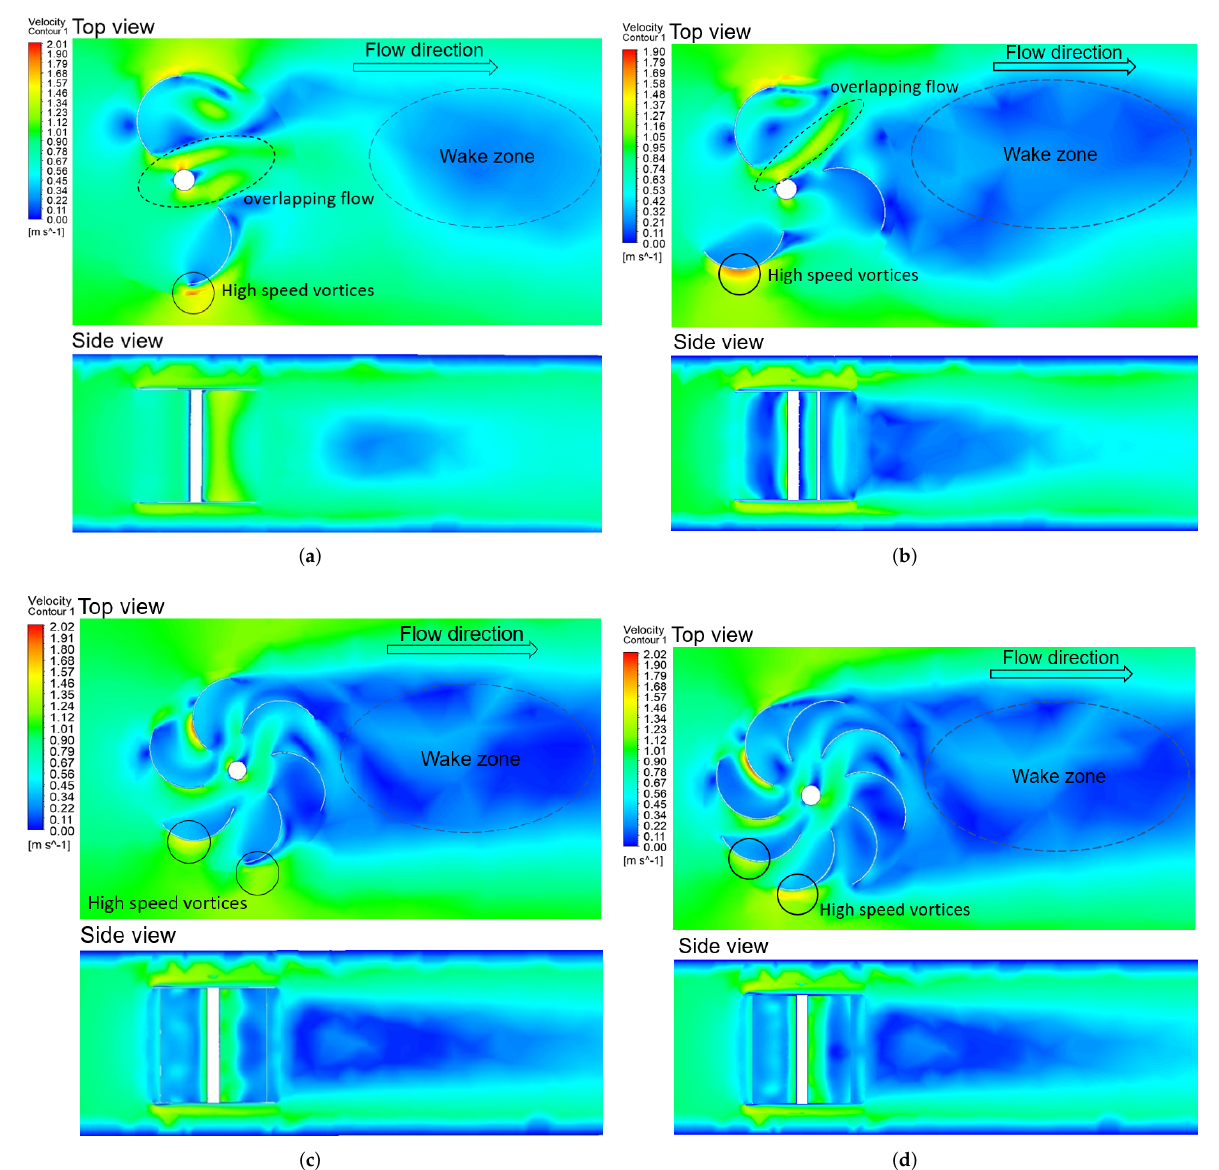
Figure 15. Comparison of the velocity distribution around the blades for ( a ) 2-bladed turbine, ( b ) 3-bladed turbine, ( c ) 6-bladed turbine, and ( d ) 8-bladed